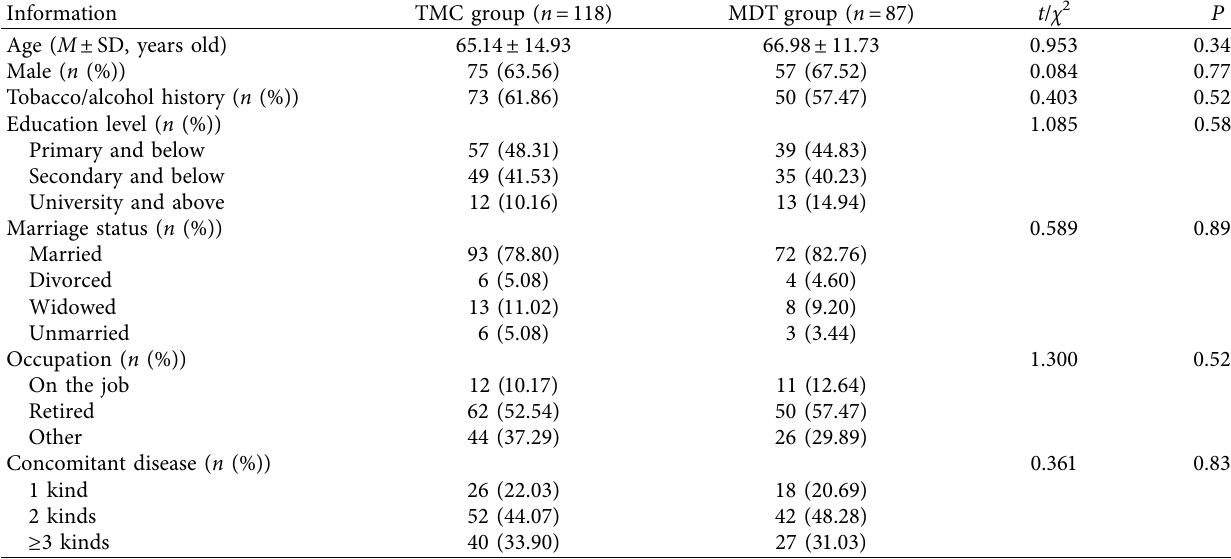
Table 1: Baseline